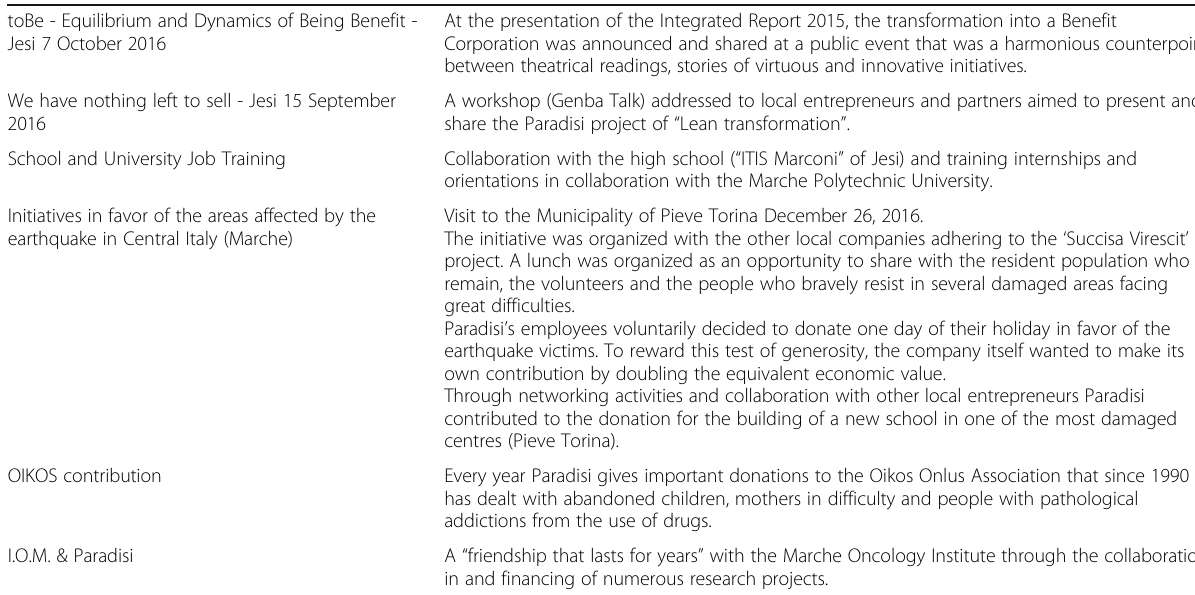
Table 3 Paradisi ’ s initiatives for the general public benefit toBe - Equilibrium and Dynamics of Being Benefit - Jesi 7 October